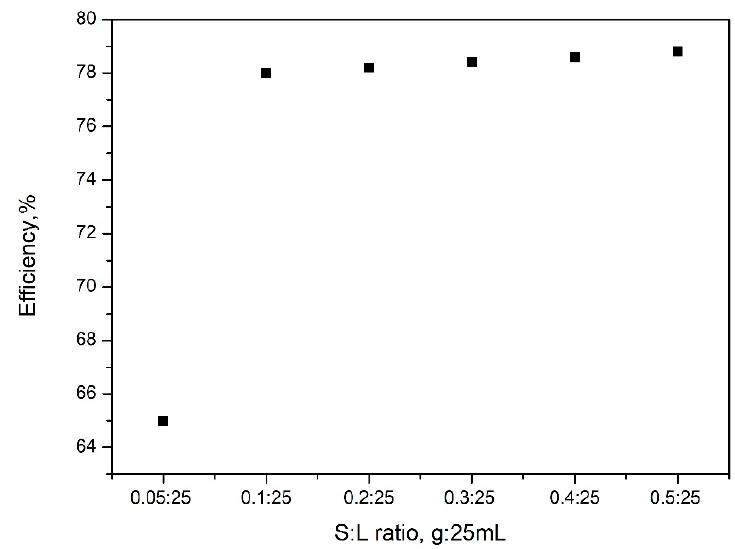
Figure 7. S:L ratio effect on adsorption efficiency.